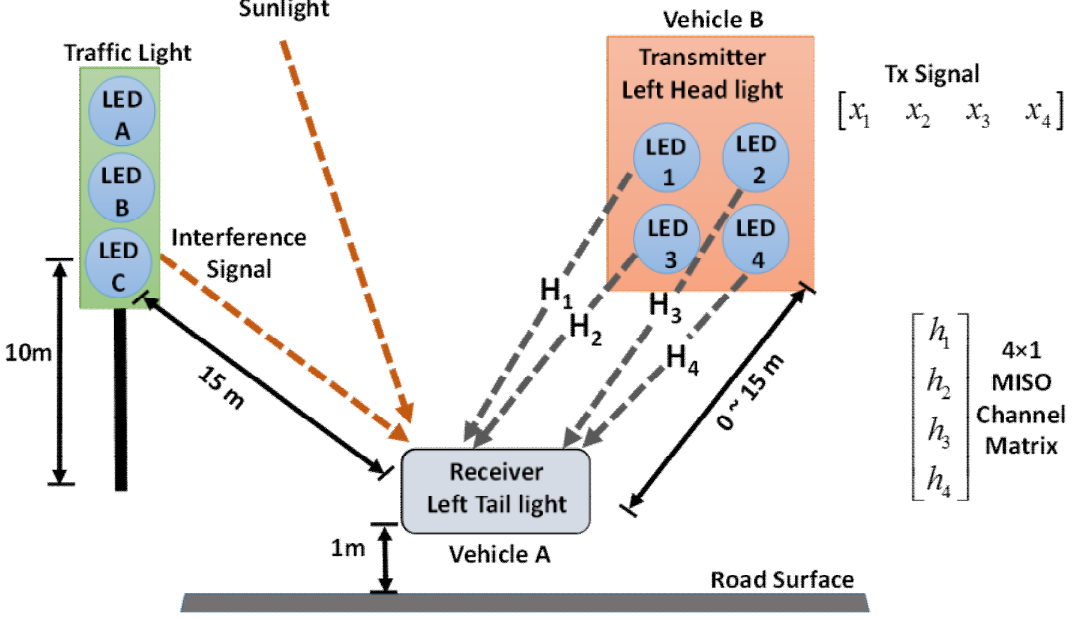
Figure 1. A 4 × 1 MISO configuration for the VLC-based ITS using the head and tail light of the vehicles.